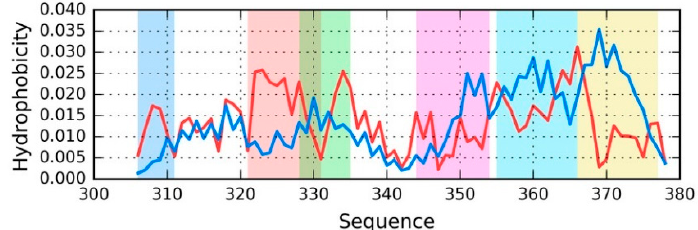
Figure 4. Theoretical (T—blue) and observed (O—red) distribution for the chain E from phf-tauO (the distribution is similar in all structural units). Fragments where O significantly deviates from T are highlighted by different colors (see Table 4) that match the colors of three-dimensional (3D) presentations on Figure 5.